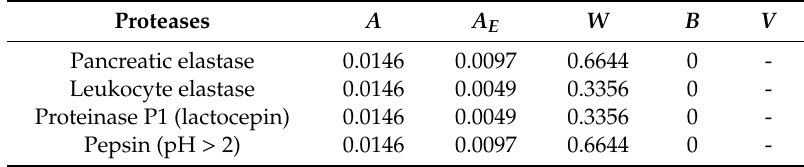
Table 4. The values of parameters describing the predicted e ffi ciency of release of bioactive activating